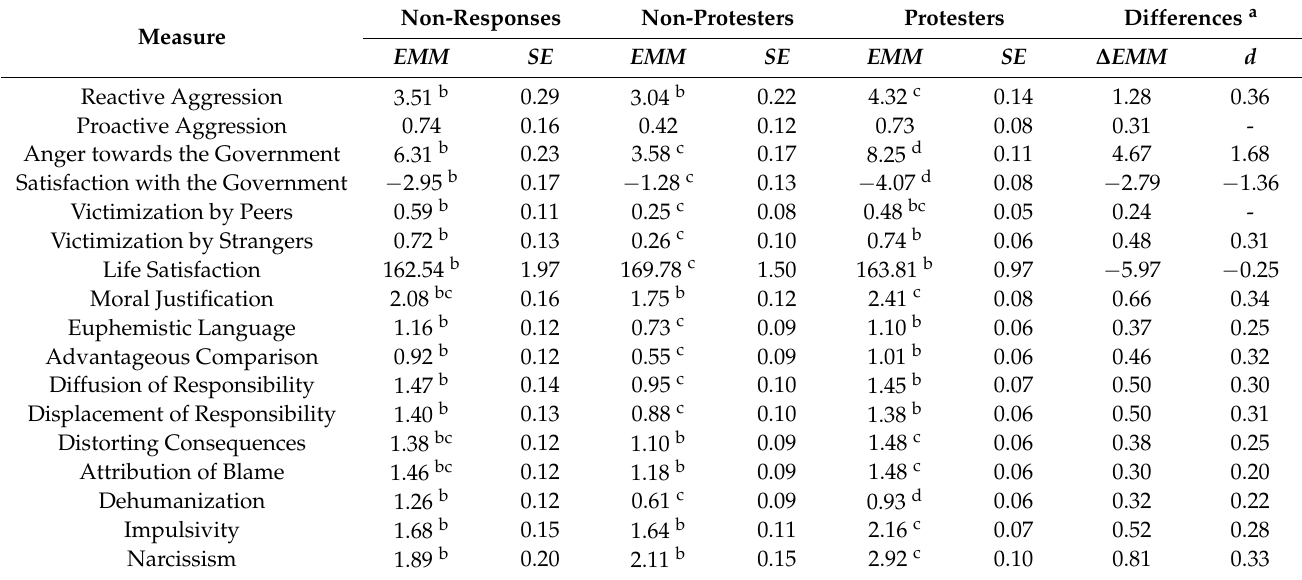
Table 5. Post hoc Comparisons among Protest Participation.